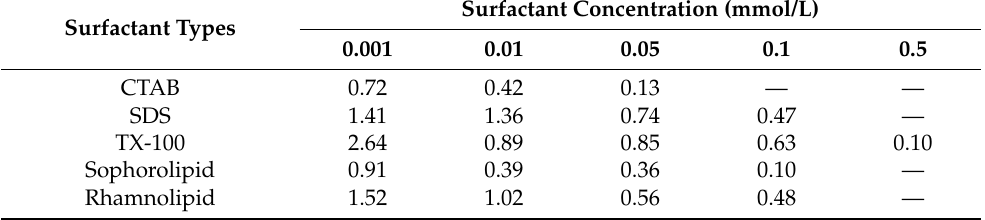
Table 4. Adhesion forces (F/R) between heavy oil and calcium carbonate in different surfactants concentrations at ambient conditions (25 ◦ C, C KCl = 1mmol/L, pH = 3.5, 45 ppm asphaltenes; F/R,